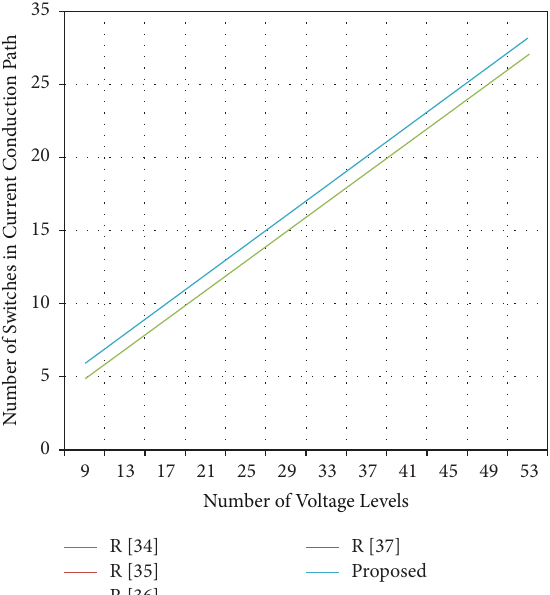
Figure 12: No. of voltage levels vs no. of switches in current conduction path.